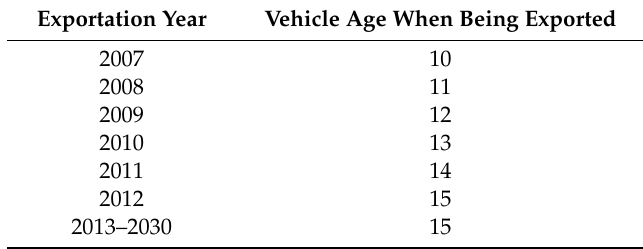
Table 1. Assumption of age for exported HV from Japan to Mongolia.